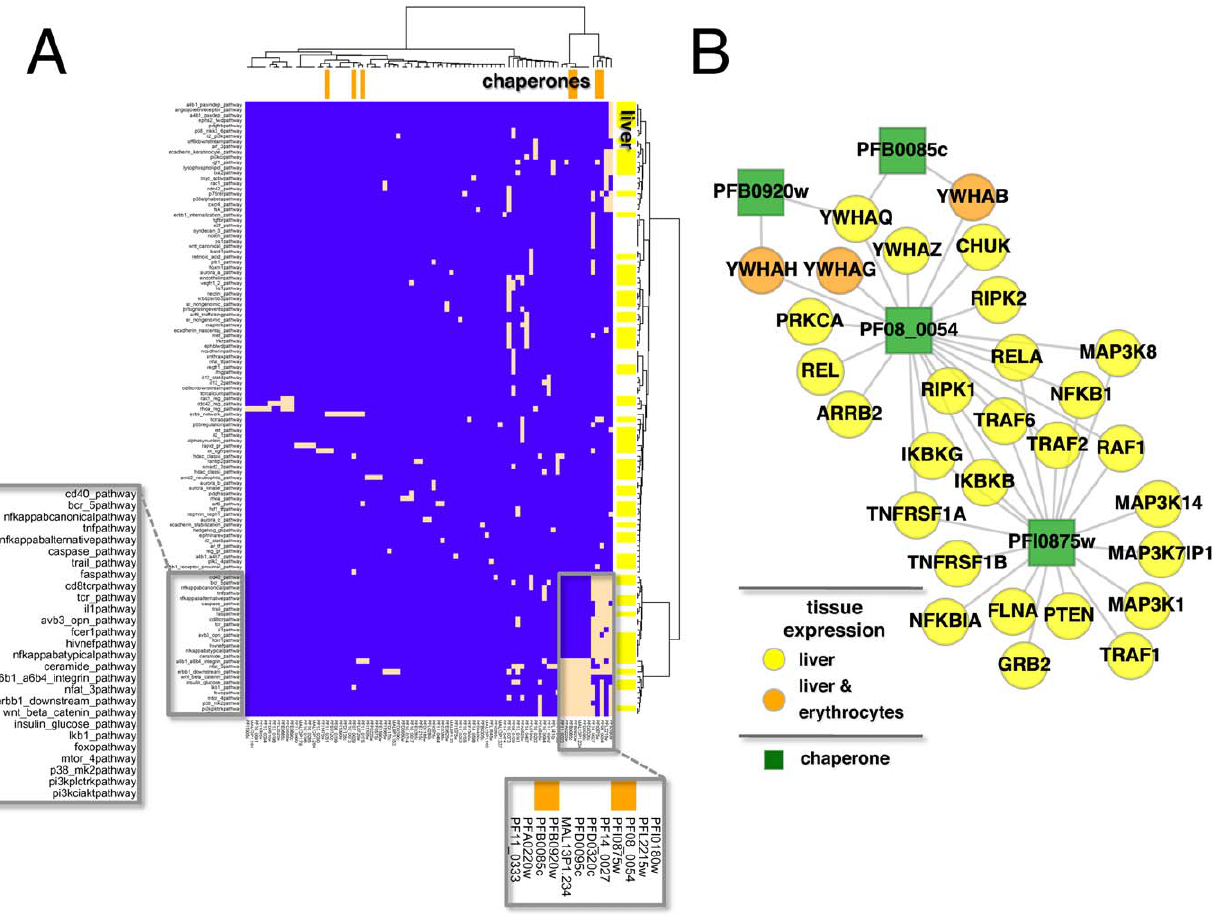
Figure 5. Involvement of host-parasite interactions in signaling pathways. ( A ) In a bipartite matrix a parasite protein was linked to a pathway if the corresponding targeted proteins were enriched in the given pathway (FDR , 0.05, Fisher’s exact test). Utilizing the combined set of host-parasite interactions the matrix was composed of 83 parasite proteins that interacted with proteins in 117 pathways. In addition, a large fraction of pathways had . 95% of their proteins being expressed in liver. Specifically, a cluster of prominent signaling pathways emerged that were largely under the control of parasite specific chaperone proteins. In ( B ) all interactions between parasite chaperones and host proteins that appeared in the cluster of pathways were mapped. Significantly, such a network revolves around parasite proteins PF08_0054 and PFI0875w that garnered most of the host-parasite interactions and largely interfered with proteins of the TNF pathway.